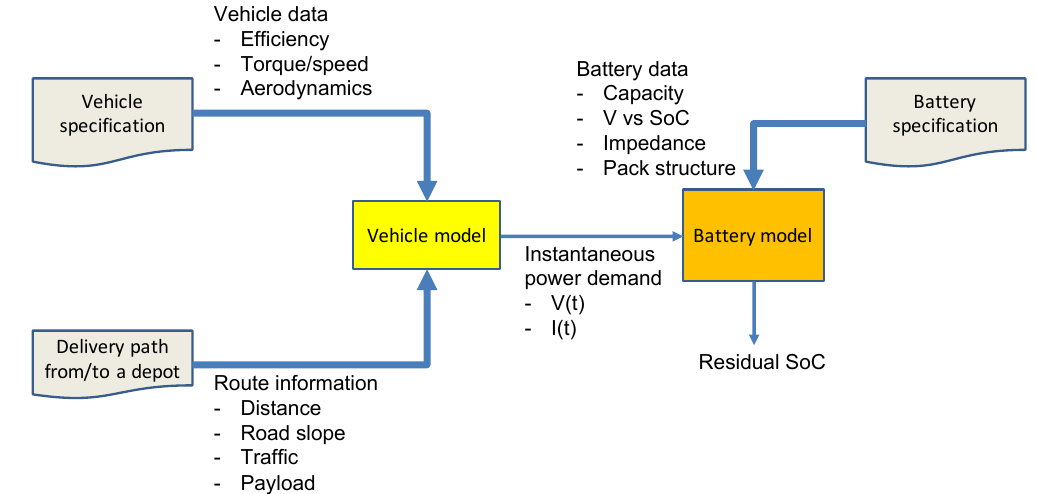
Figure 4. Overall concept of the proposed